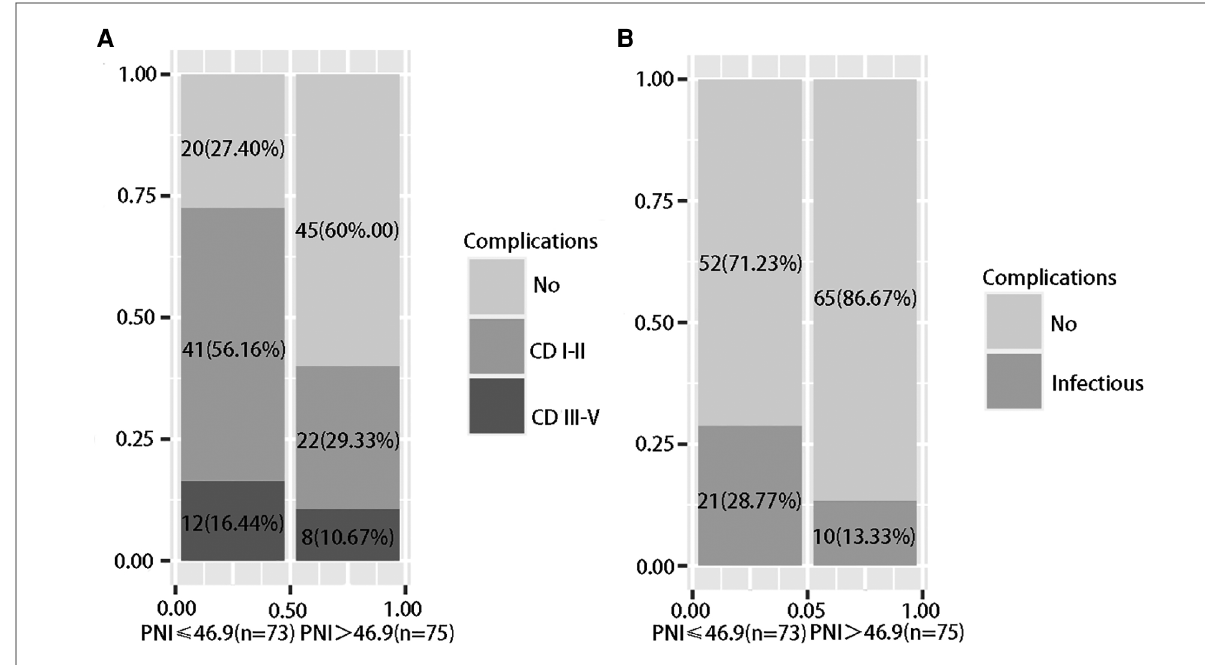
FIGURE 3 ( A ) Frequency of postoperative complications; ( B ) Frequency of infectious